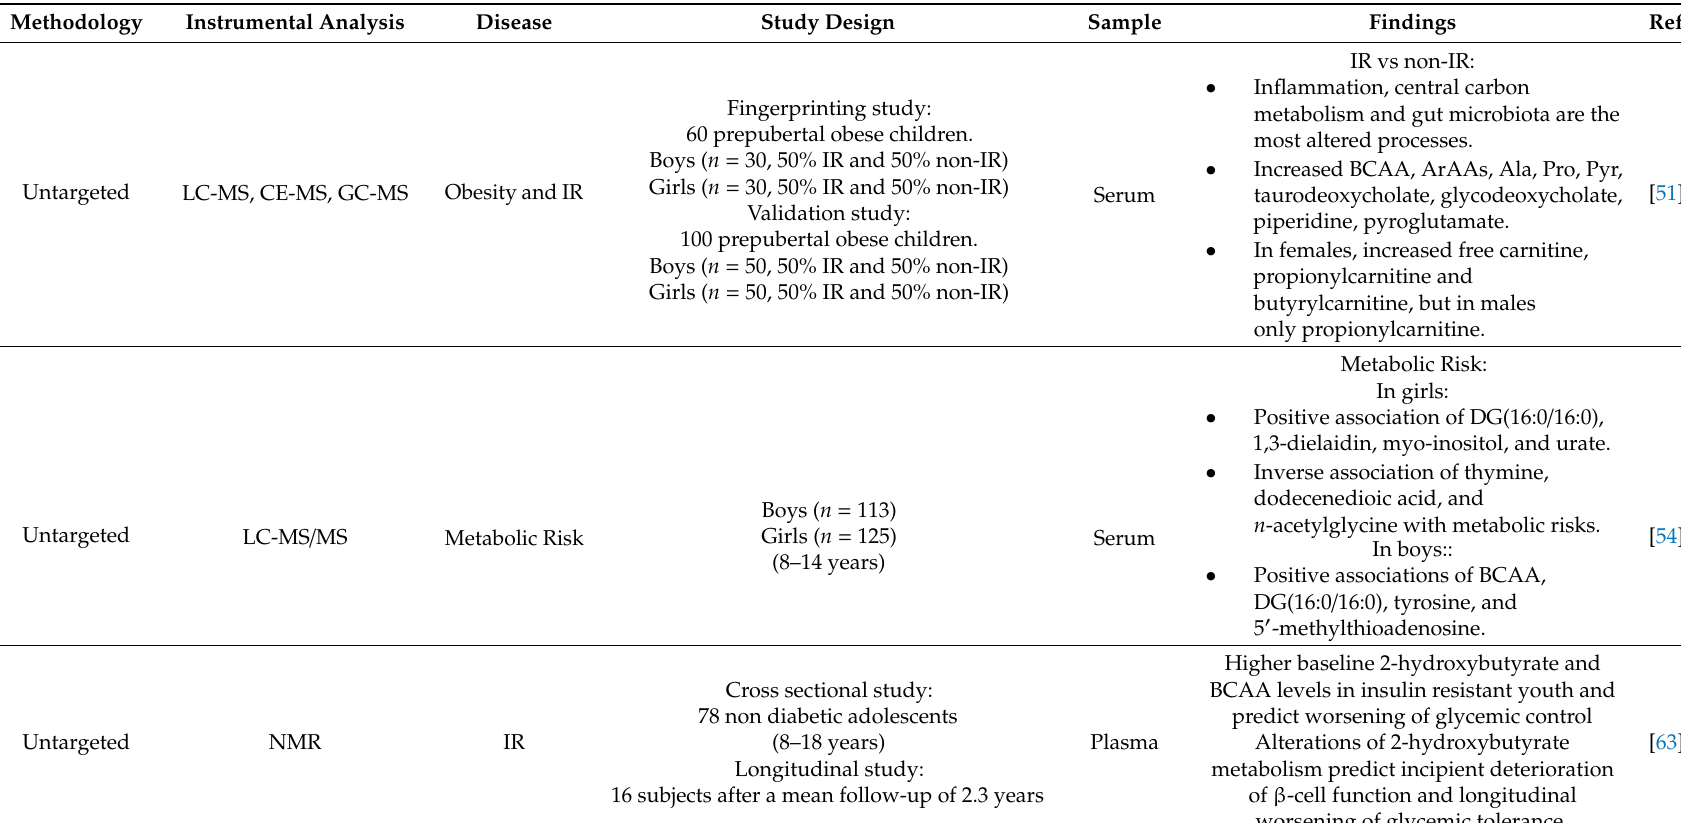
Table 1. Metabolomic studies about obesity, insulin resistance or type 2 diabetes mellitus (T2DM) in